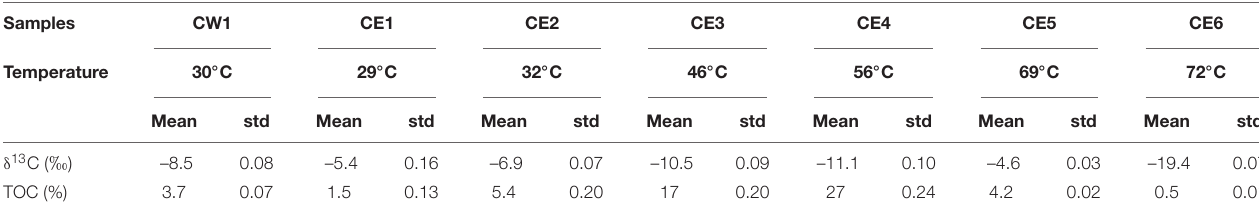
TABLE 2 | Bulk geochemical characterization of the biofilms from the West and East branches of the Cacao hydrothermal stream (for CE4gr, there was no sufficient material for conducting the bulk geochemistry analysis). Samples CW1